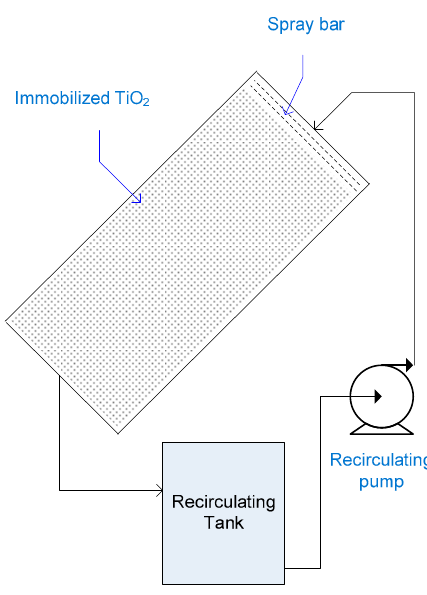
Figure 4. Schematic drawing of TFFBR (Thin ‐ film fixed ‐ bed reactor) system.